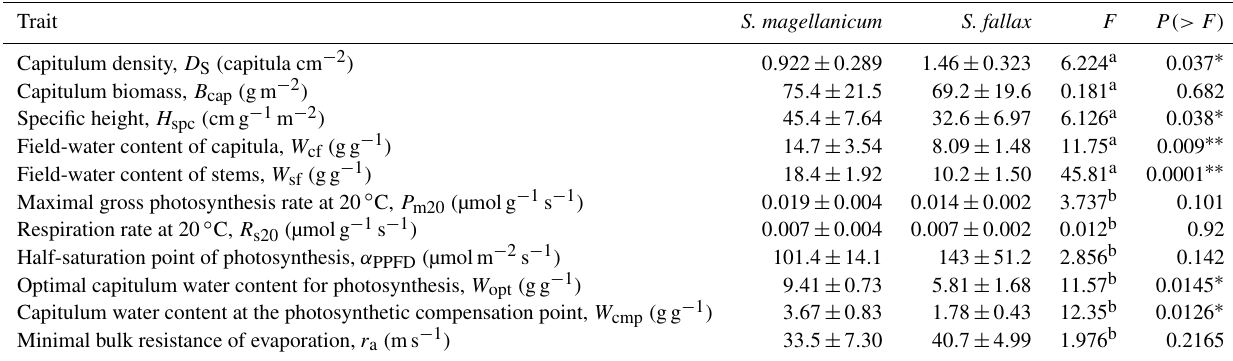
Table B1. Species-specific morphological, photosynthetic, and water retention traits from S. magellanicum and S. fallax . Trait values (mean ± standard deviation) and ANOVA statistics, F and p values, are given to compare the mean values of traits for the two species. Trait S. magellanicum S. fallax